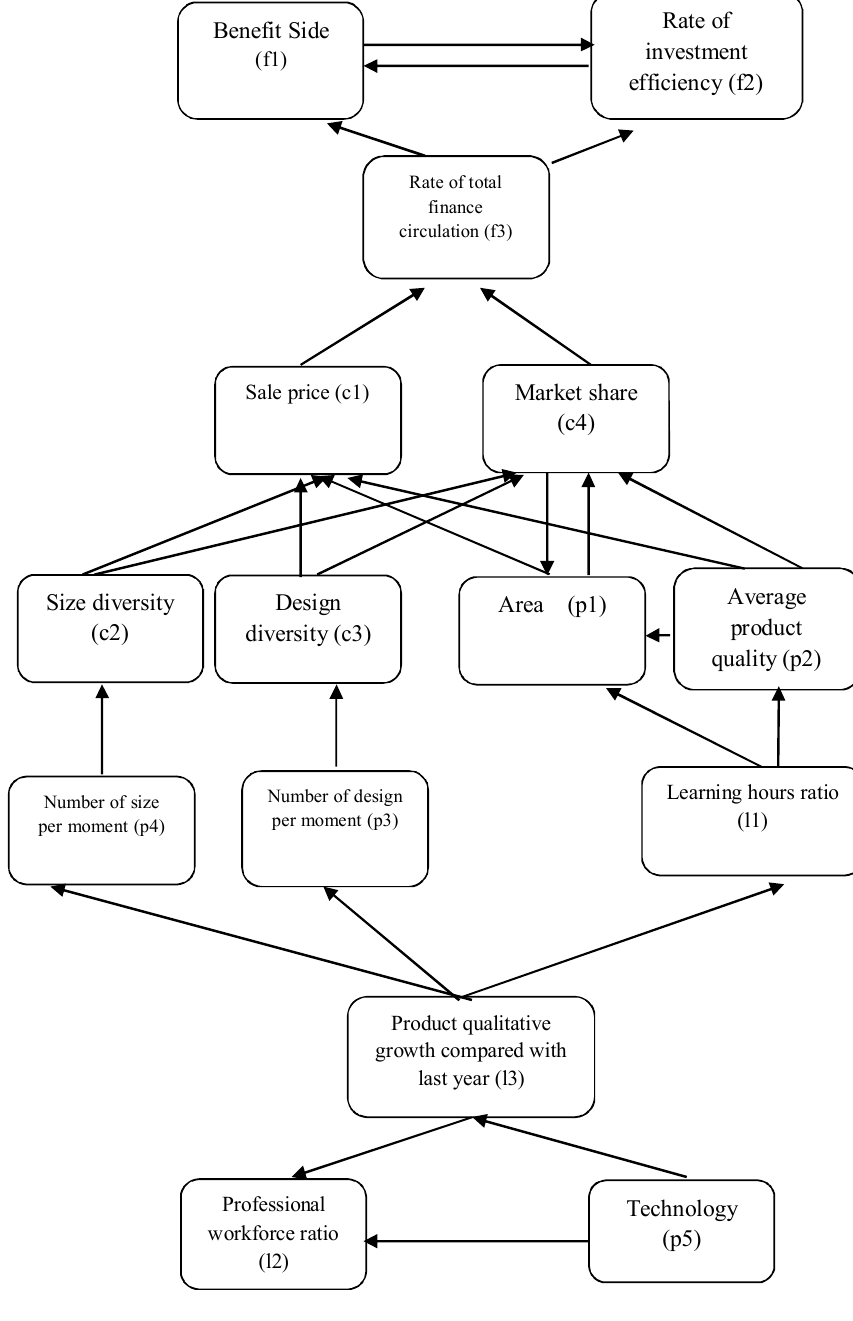
Fig. 2. Leveled diagraph of function assessment measures in tile and ceramic industry